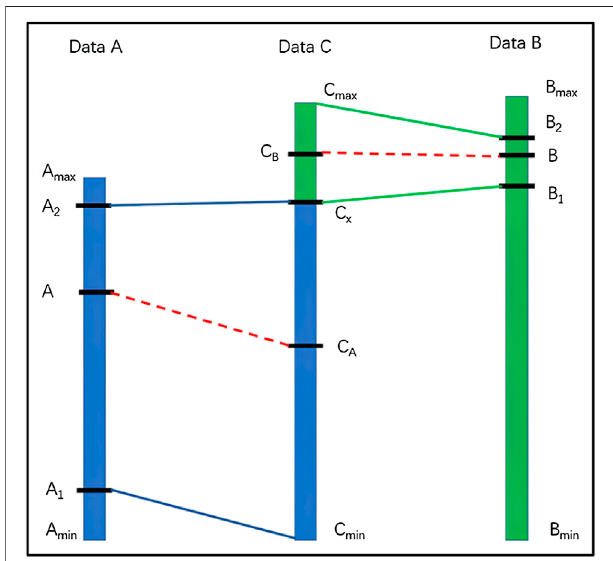
FIGURE 4 | Schematic diagram of attribute proportion fusion